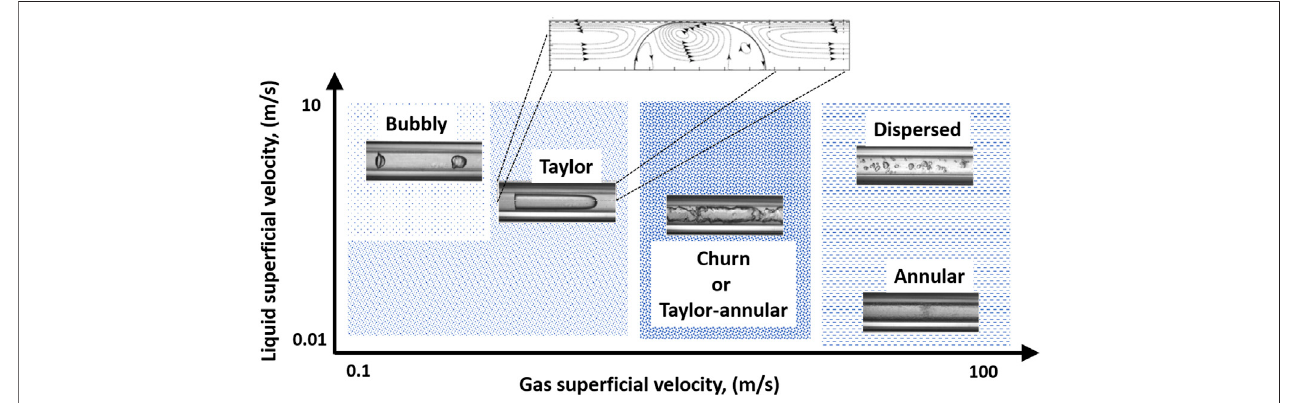
FIGURE 1 | Flow patterns for gas-liquid fl ow depending on the gas and liquid fl ow rates. The modi fi ed image is adapted from Shao et al.,